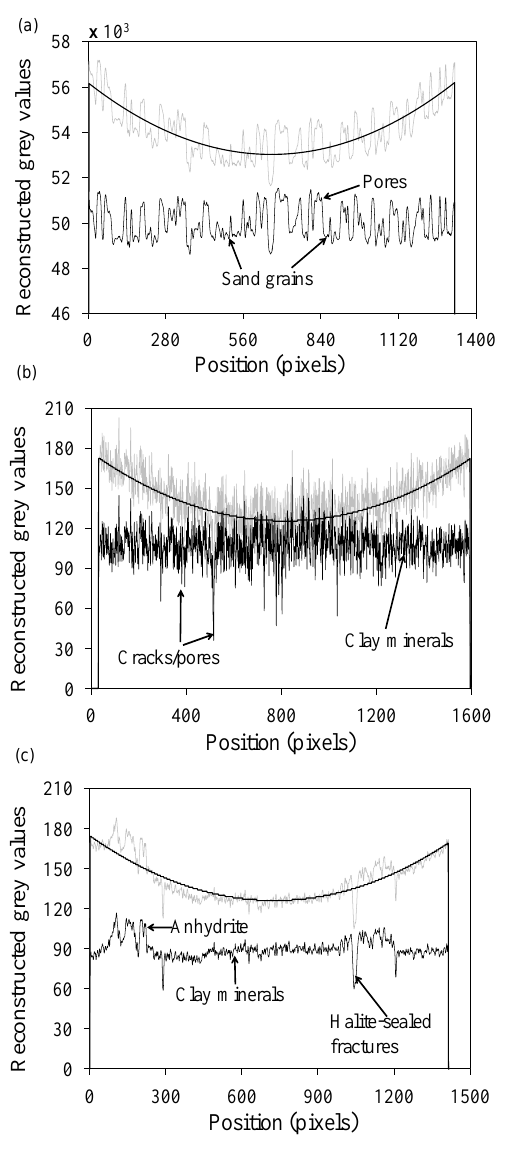
Figure 5. Plot of grey values of BH correction by our proposed method. The curves in plot (a) , (b) , and (c) represent the BH cor- rection corresponding to the images in Fig. 3a, b, and c, respectively. The light-grey colours show the grey values of the BH-uncorrected images, which are extracted row-wise (horizontally) at the centre of each image. The black solid curves represent the residual grey-scale range of values as a result of the fitting.